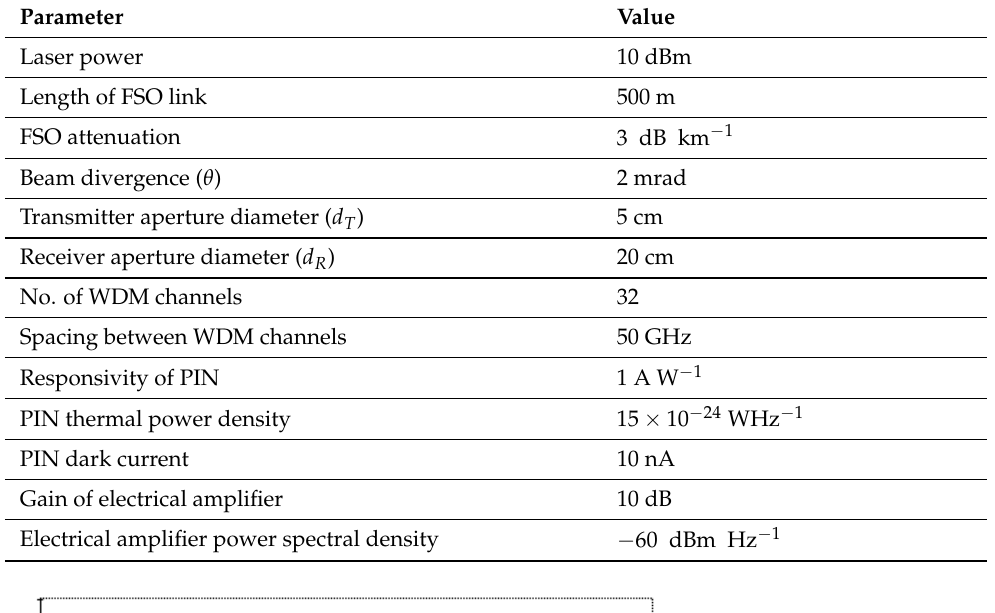
Table 2. Simulation parameters.